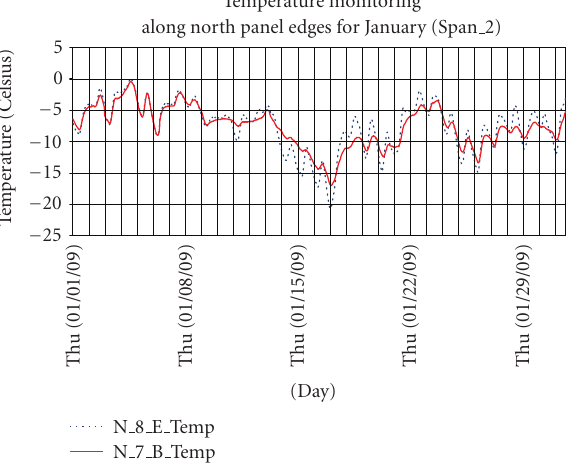
Figure 6: North longitudinal load stress monitoring for span two (1/17/09).